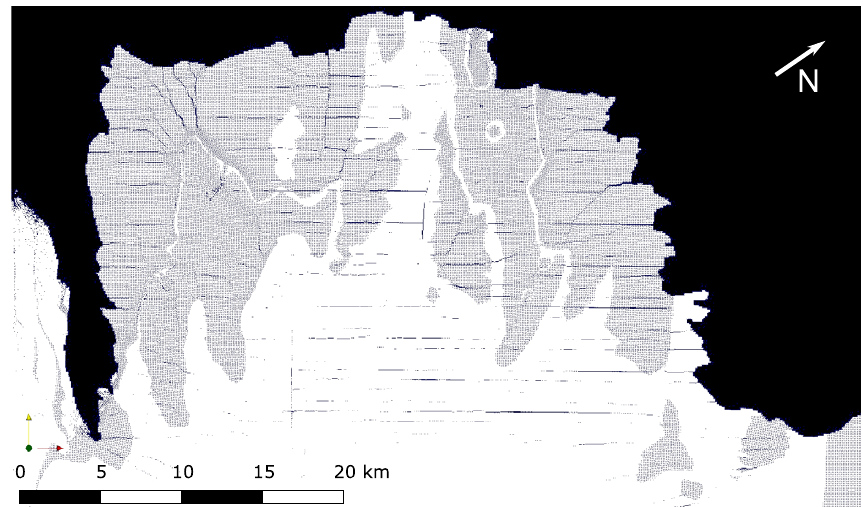
Figure 6. Fracture pattern produced by HiDEM with artificial basal crevasses. In this projection thick ice appears white, thin ice appears grey and fractures are visible as dark lines on the ice shelf. The introduced basal features are a source of additional across-flow fracture, producing a checkerboard fracture pattern similar to observation.